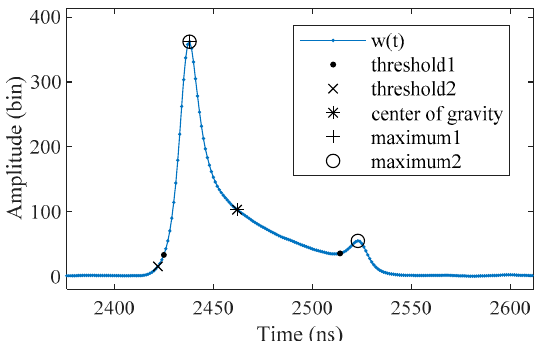
Figure 7. Comparison of the conventional signal detection methods, where “ threshold1 ” used a threshold that was equal to one-tenth of the maximum amplitude of w R ( t ) ( M A ), “ threshold2 ” used a threshold that was equal to 0.05 M A , “ maximum1 ” used a threshold that was equal to 0.2 M A , and “ maximum2 ” used a threshold that was equal to 0.1 M A